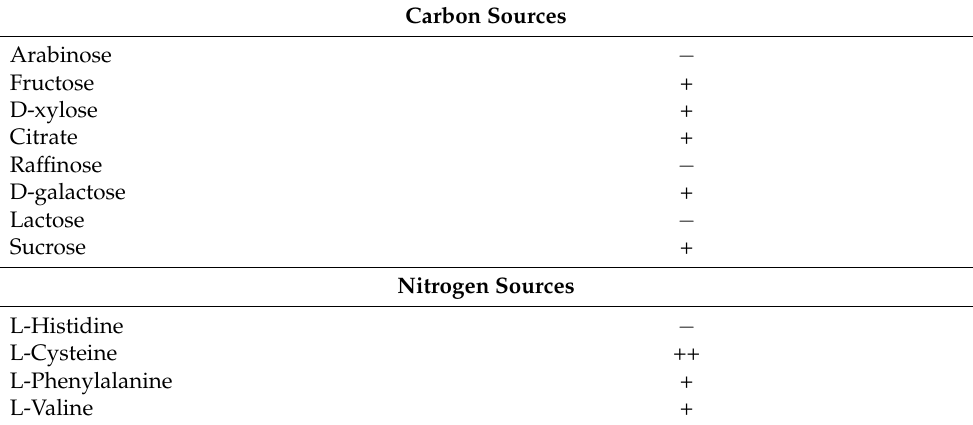
Table 4. Growth at different carbon and nitrogen sources of Streptomyces sp. strain ess_amH1.